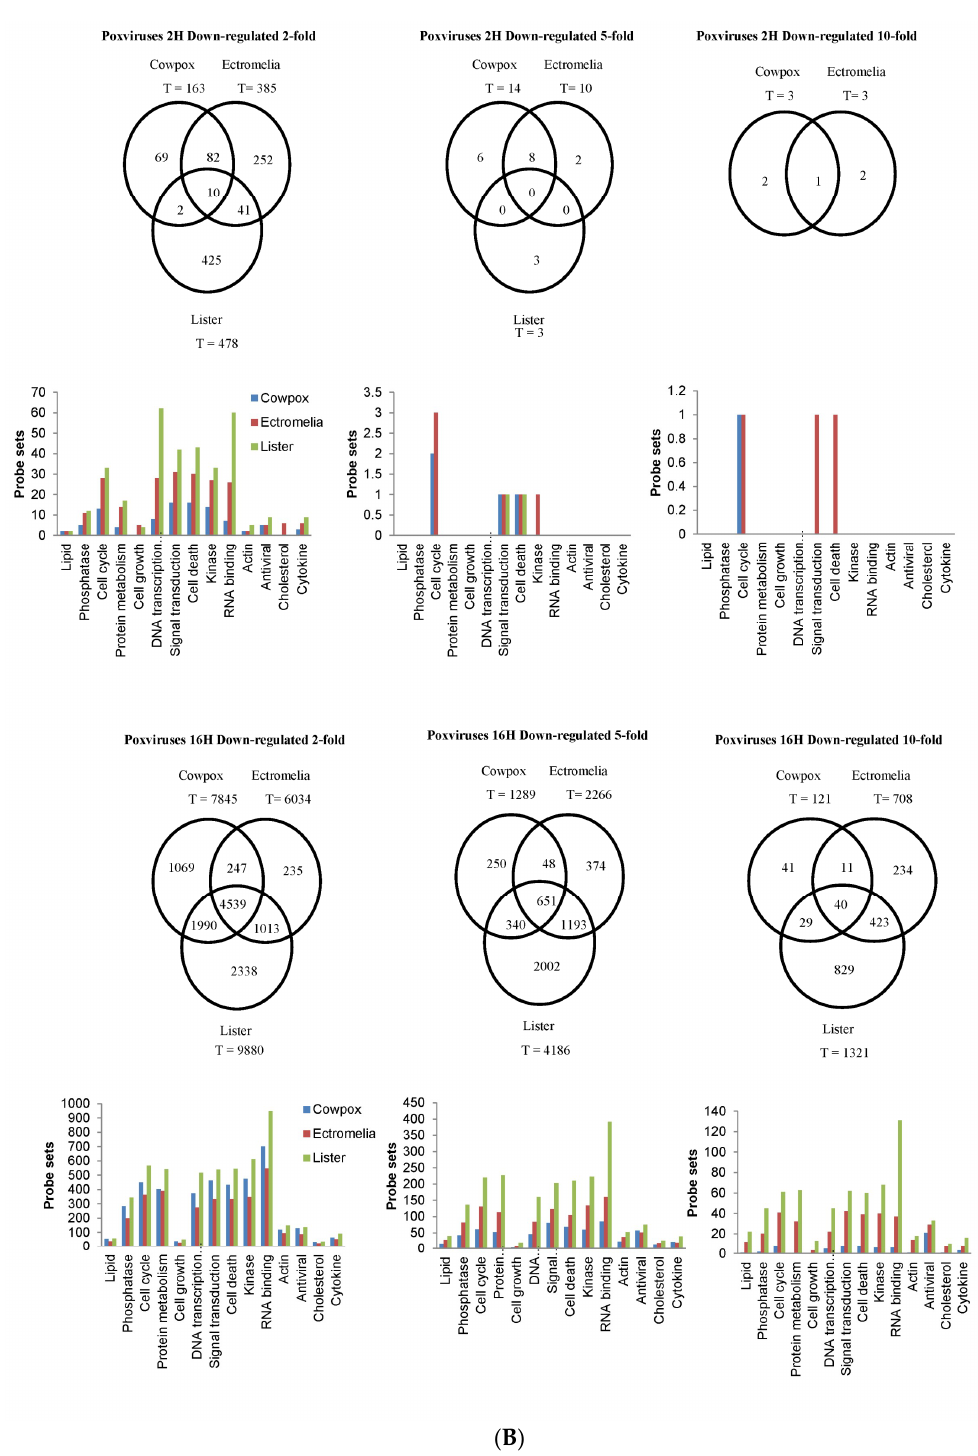
Figure 2. Temporal changes in global host cell gene expression in RAW cells infected with cowpox virus, ectromelia virus and vaccinia virus (Lister). The probe-sets showing significantly ( A ) up-regulated and ( B ) down-regulated gene expression at 2 h post-infection (2H) and 16 h post-infection (16H) are shown respectively in Venn diagrams and bar charts. In the bar chart, number of probe-sets are represented on the y-axis and the functional genes are represented in the x-axis. Changes in expression levels are based on 2, 5 and 10-fold changes (FC) ( p ≤ 0.05).